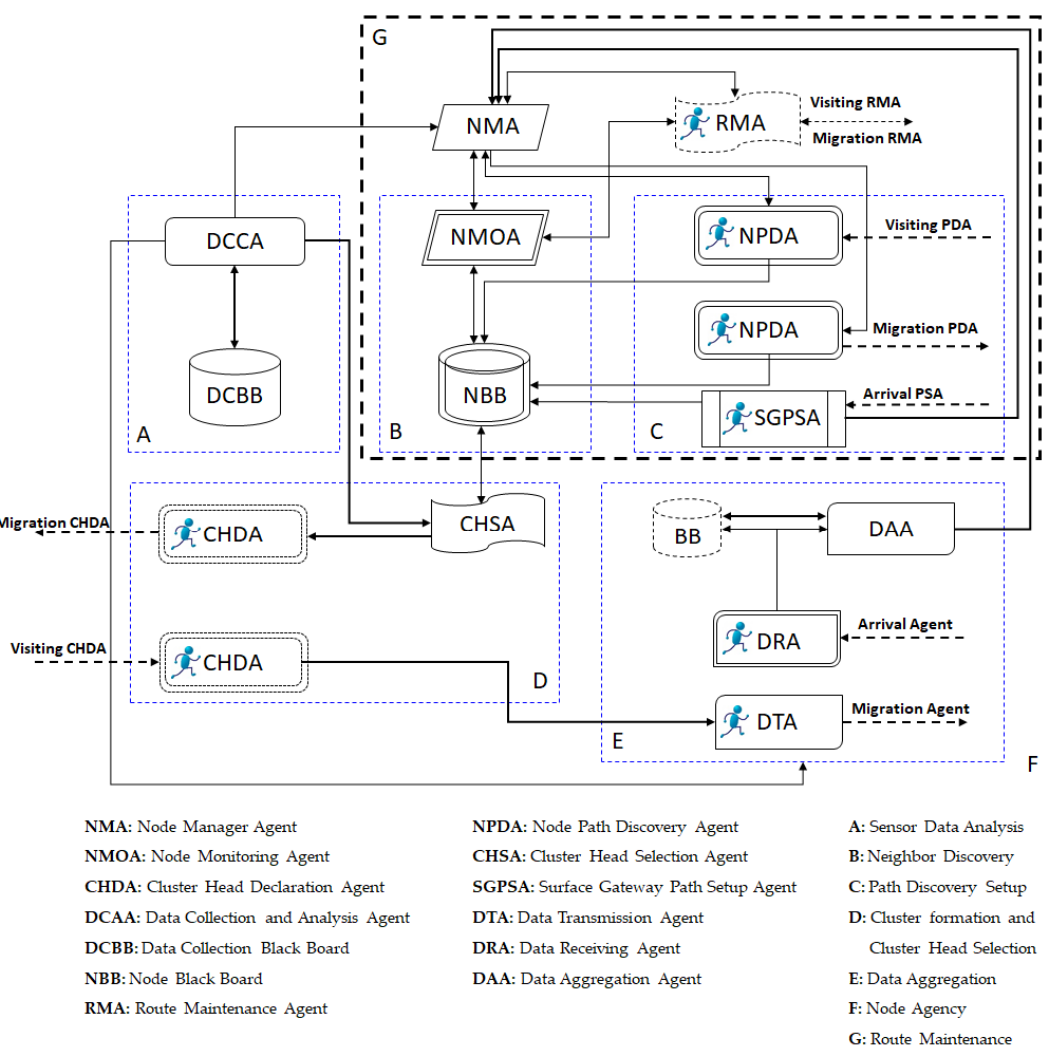
Figure 4. Node Figure 4. Node agency.